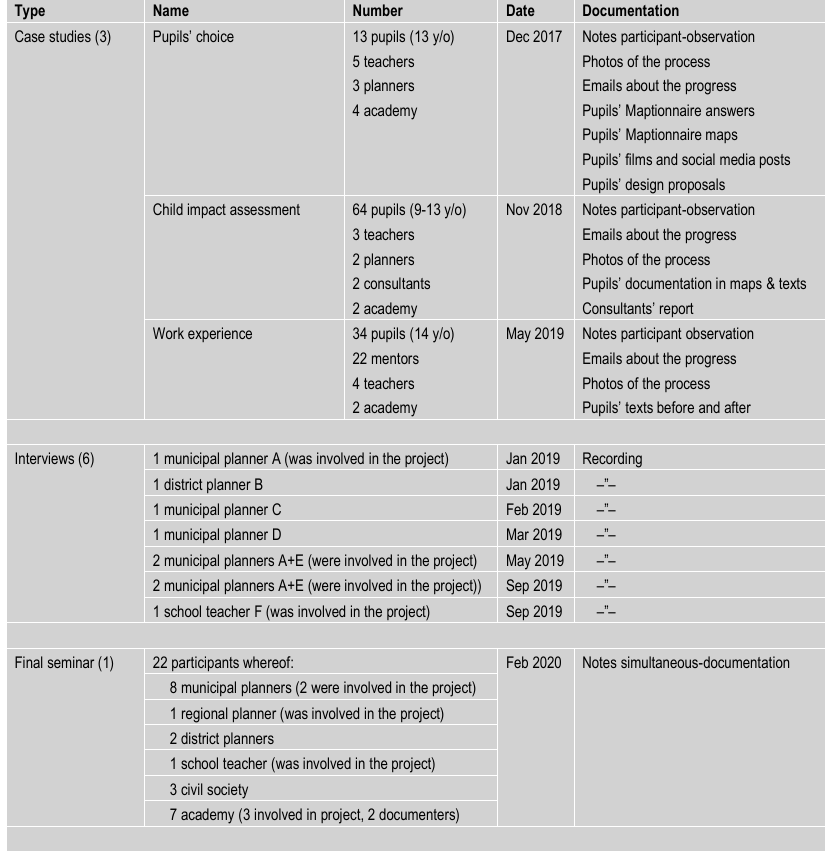
Figure 1. Picture of the project’s empirical material.